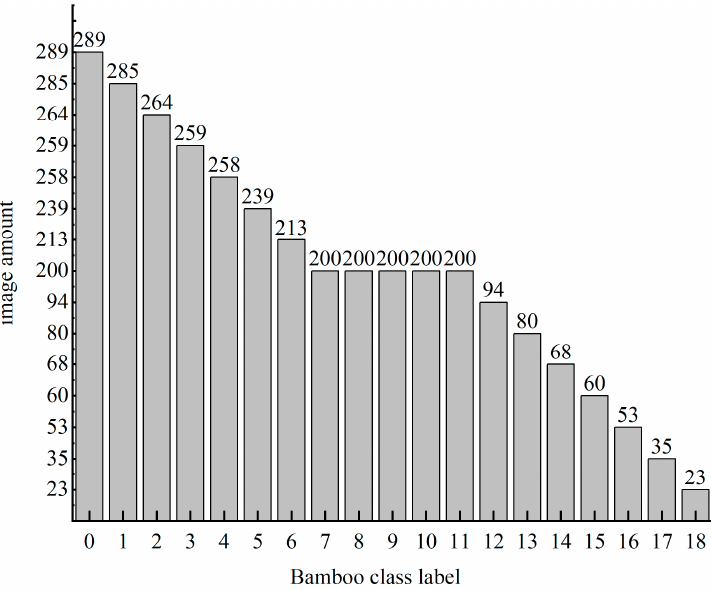
Figure 6. Quantity statistics of each class of the bamboo dataset.